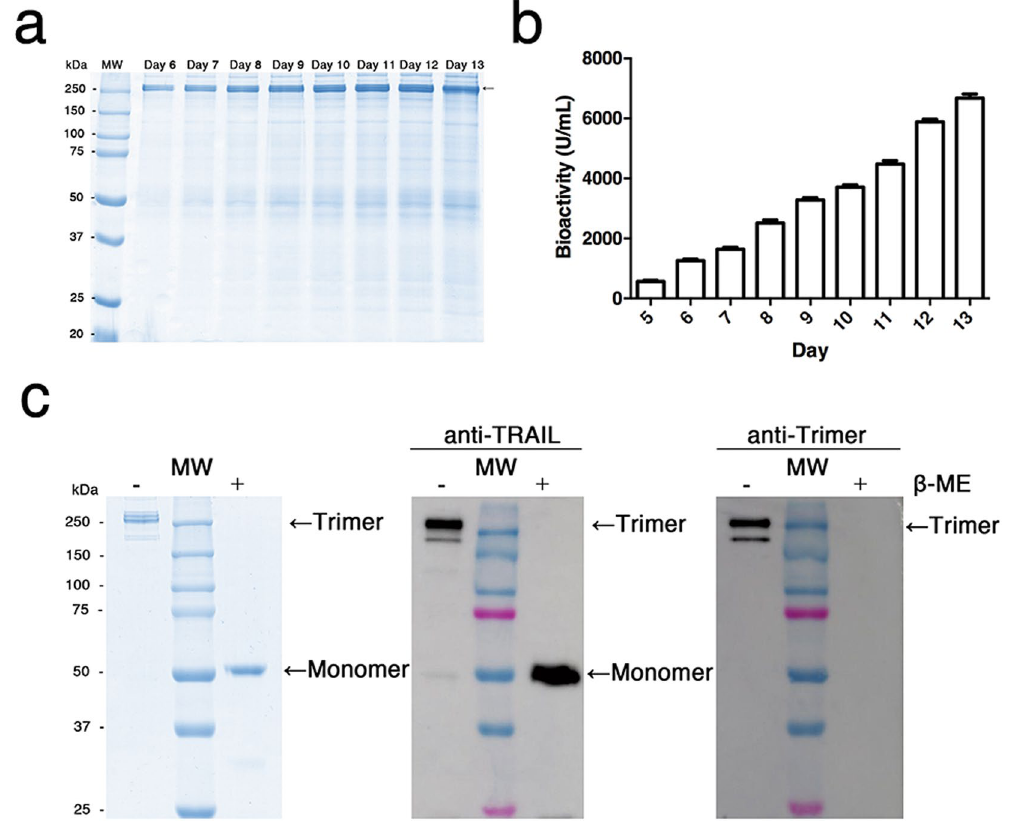
Figure 2. High-level expression and purification of TRAIL-Trimer fusion protein. ( a ) 10% SDS-PAGE analysis of TRAIL-Trimer expression from a fed-batch serum-free cell culture in the bioreactor. 10 µ L of cell- free conditioned medium from Day 6 to Day 13 were analyzed under non-reducing condition followed by Coomassie Blue staining. ( b ) Bioassay analysis of TRAIL-Trimer production in conditioned medium from Day 5 to Day 13. ( c ) SDS-PAGE and western blot analysis of purified TRAIL-Trimer under either non-reducing or reducing conditions. 2 µ g of purified protein was analyzed by a 10% SDS-PAGE and stained with Coomassie Blue. 0.2 µ g of purified protein was analyzed by western blot using monoclonal antibody against TRAIL-domain and Trimer-domain,